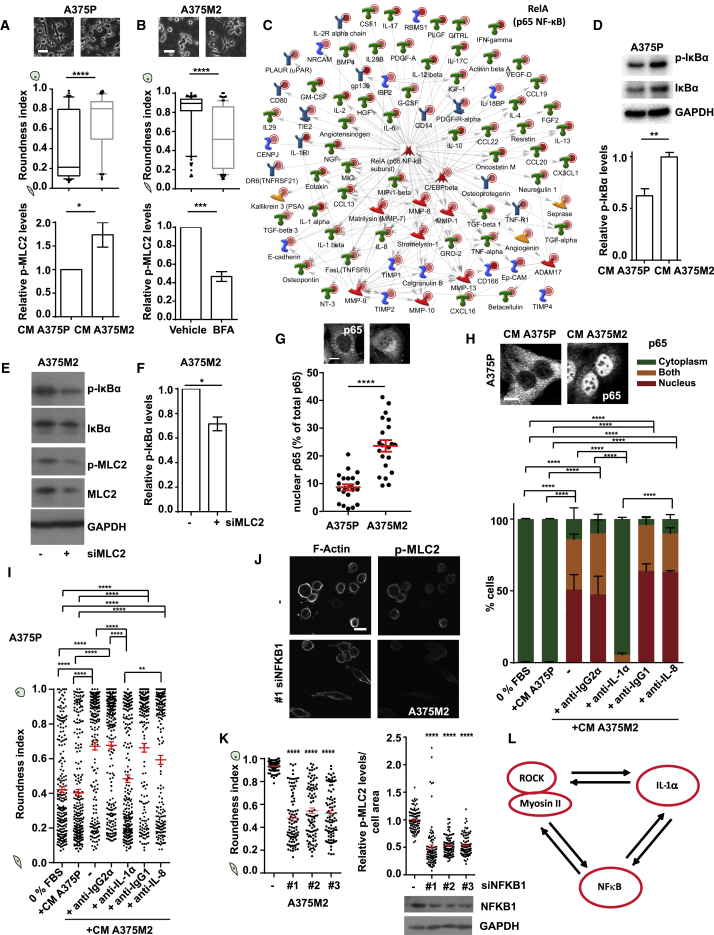
Myosin II Activity in Melanoma Cells Is Self-Perpetuated via Secreted IL-1α-Induced NF-κB Activation(A and B) (Top) Images, (center) roundness index, and (bottom) relative p-MLC2 levels of (A) A375P cells on top of collagen I upon treatment with CM A375P or CM A375M2 and (B) A375M2 cells upon treatment with BFA for 6 h. Data are presented as fold change versus the control (n = 3).(C) MetaCore enrichment network of factors upregulated in A375M2 cells is centered on NF-κB.(D) (Top) Immunoblot and (bottom) quantification of p-IKBα levels in A375P cells treated with CM A375P or CM A375M2. Data are presented as fold change versus CM A375M2 treatment (n = 3).(E and F) Immunoblot (E) and quantification (F) of p-IKBα levels in A375M2 cells after MLC2 knockdown. Data are presented as fold change versus control (n = 2).(G) (Top) Confocal images and (bottom) quantification of nuclear p65, as percentage versus the total p65, in A375P and A375M2 cells. Each dot represents a different cell. Scale bar, 10 μm.(H) (Top) Confocal images for p65 in A375P cells after treatment with CM A375P or CM A375M2. Scale bar, 10 μm. (bottom) Percentage of A375P cells with p65 in the cytoplasm (green), nucleus (red), or in both (orange) after indicated treatments. Blocking was for 1 h at 37°C (n = 3; 3 pictures per experiment; total 9 pictures per condition).(I) Roundness index of A375P cells on collagen I after same treatments as in (H) (n = 3).(J) Confocal images of p-MLC2 and F-actin in NFKB1 depleted A375M2 cells. Scale bar, 20 μm.(K) (Left) Roundness index and (right) relative p-MLC2 levels in A375M2 cells after NFKB1 knockdown, from confocal images (30 cells/condition, each dot represents a single cell). (K bottom right) Representative immunoblot showing NFKB1 knockdown in A375M2 cells.(L) Schematic: cross-talk between ROCK-Myosin II, secreted IL-1α, and NF-κB activation in amoeboid melanoma cells.In (A, center) and (B, center), boxplots show 10–90 percentile. In (A, bottom) and (B, bottom), (D), (F)–(I), and (K), graphs and dot blots show mean ± SEM. In (A), (B), (D), (F), and (G), t test is shown. In (H), (I), and (K), one-way ANOVA with Tukey post hoc test is shown. ∗p < 0.05, ∗∗p < 0.01, ∗∗∗p < 0.001, ∗∗∗∗p < 0.0001.See also Figure S6.